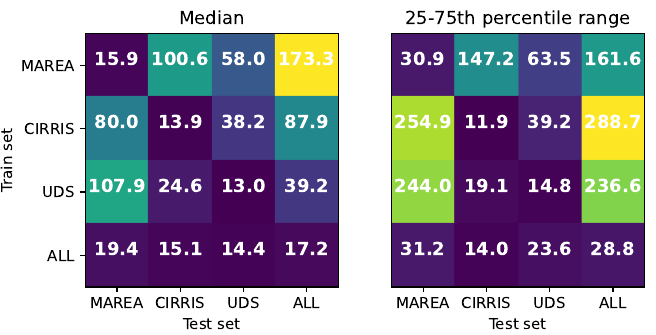
Figure 8. MAE (ms) of the prediction with the ESN on HS and TO events as a function of the training/testing database combination considering all walking condition subsets MAR all , CIR all and UDS all